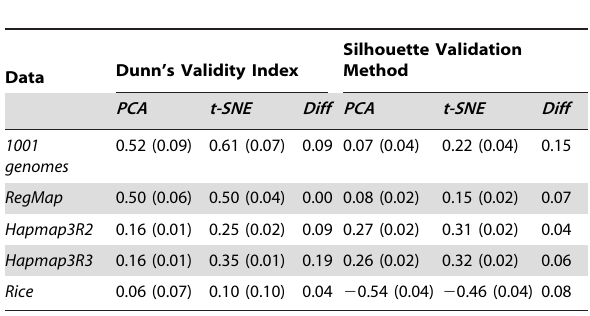
Table 1. Dunn’s Validity Index and Silhouette Validation Method of the transformed SNP